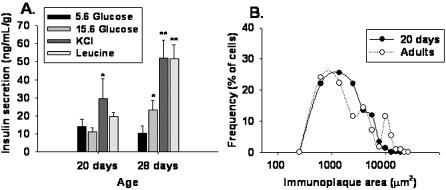
Insulin secretion and functional subpopulations from isolated beta cells at d20 and d28. (A) Bar graphs represent the release of insulin by isolated d20 and d28 beta cells in response to glucose, 40 mM KCl and 10 mM leucine, measured by ELISA; mean ± SEM, n  =  3 experiments by duplicate.Symbols denote statistically significant differences, (*) p<0.01 with respect to control, (**) p<0.001 with respect to control.
(B) Frequency distribution of insulin immunoplaque areas of beta cells at d20 and d90 stimulated with 15.6 mM glucose, measured by a RHPA; n  =  4 experiments by duplicate.